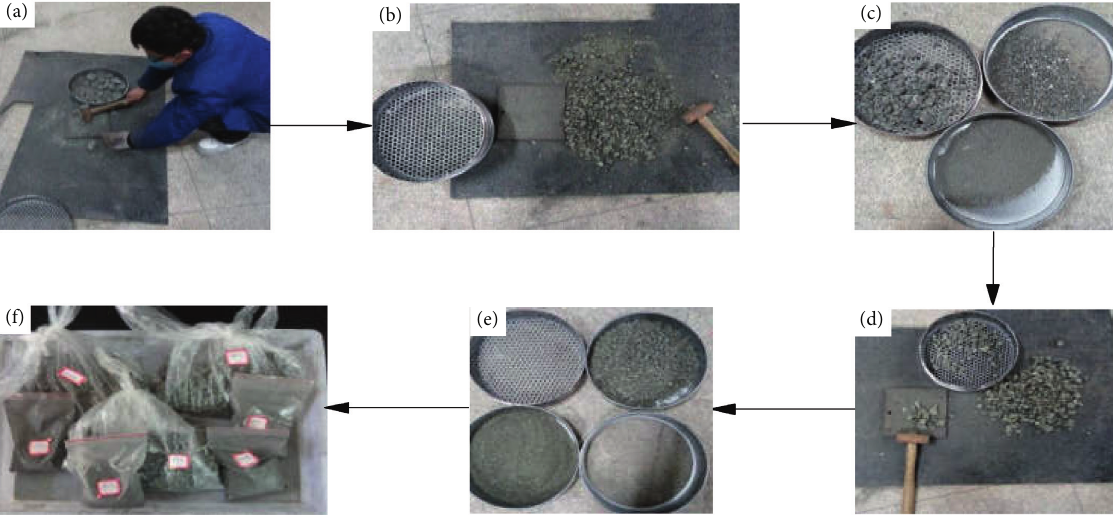
Figure 2: Coarse crushing process of ore